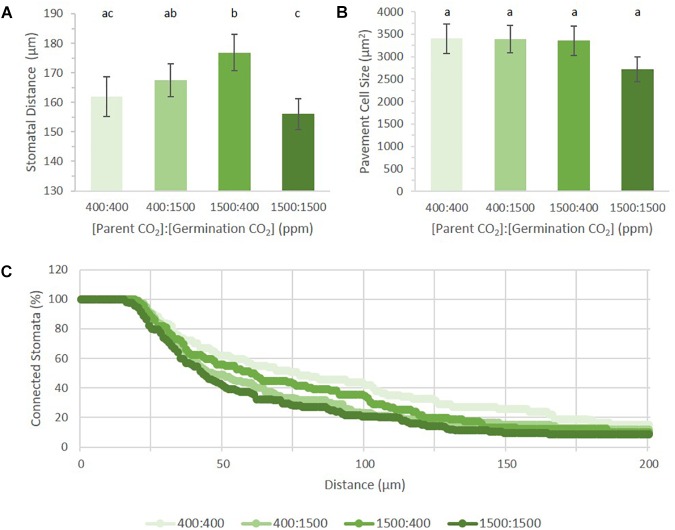
Stomatal distribution on cotyledons from seed set and germinated in differing p[CO2] environments (error bars, s.e.m.; n = 10). (A) Average distance between two stomata across four treatments. (B) Average pavement cell size in four treatments. (C) Persistent homology based method describing distribution of stomata across the image. Individual treatment combinations are significant (p = 0.03). Letters indicate similarity based on a p-value of 0.05 for independent pair-wise comparisons.